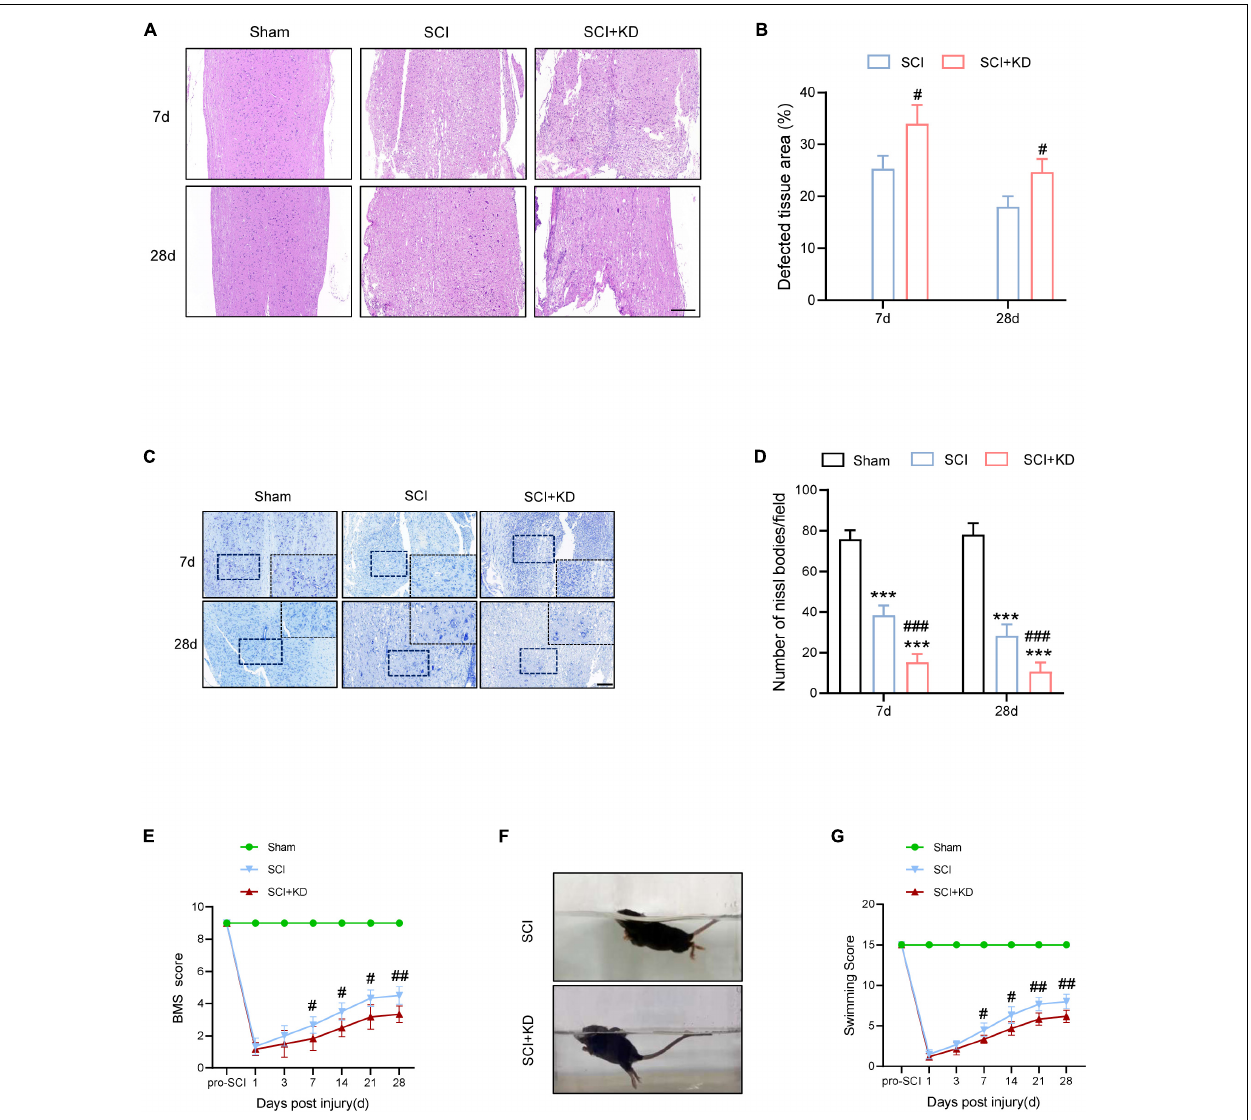
FIGURE 6 | Knockdown of GDF15 interferes locomotor recovery by aggravated neuronal loss in SCI mice. (A) H&E staining images of cords centered around the injured core 3 mm obtained at 7 and 28 dpi (Scale bar = 300 µ m). (B) Quantitative analysis of the defected area at 7 and 28 dpi ( n = 6). (C) Representative images for Nissl staining obtained from longitudinal sections centered around the injured core 1.5 mm at 7 and 28 dpi in Sham, SCI, and SCI + KD mice (Scale bar = 200 µ m). (D) Quantitative analysis of the amounts of survived neurons at 7 and 28 dpi ( n = 6). (E) The BMS score post SCI in Sham, SCI, and SCI + KD mice. (F,G) Photographs of Swimming at 28 dpi, showing the worse trunk instability and uncoordinated action in SCI mice, and statistical analysis of the Louisville Swim Scale over a period of 28 days ( n = 6). *** p < 0.001, vs. Sham group; # p < 0.05, ## p < 0.01, ### p < 0.001, vs. SCI group by two-way ANOVA followed by Tukey’s post hoc